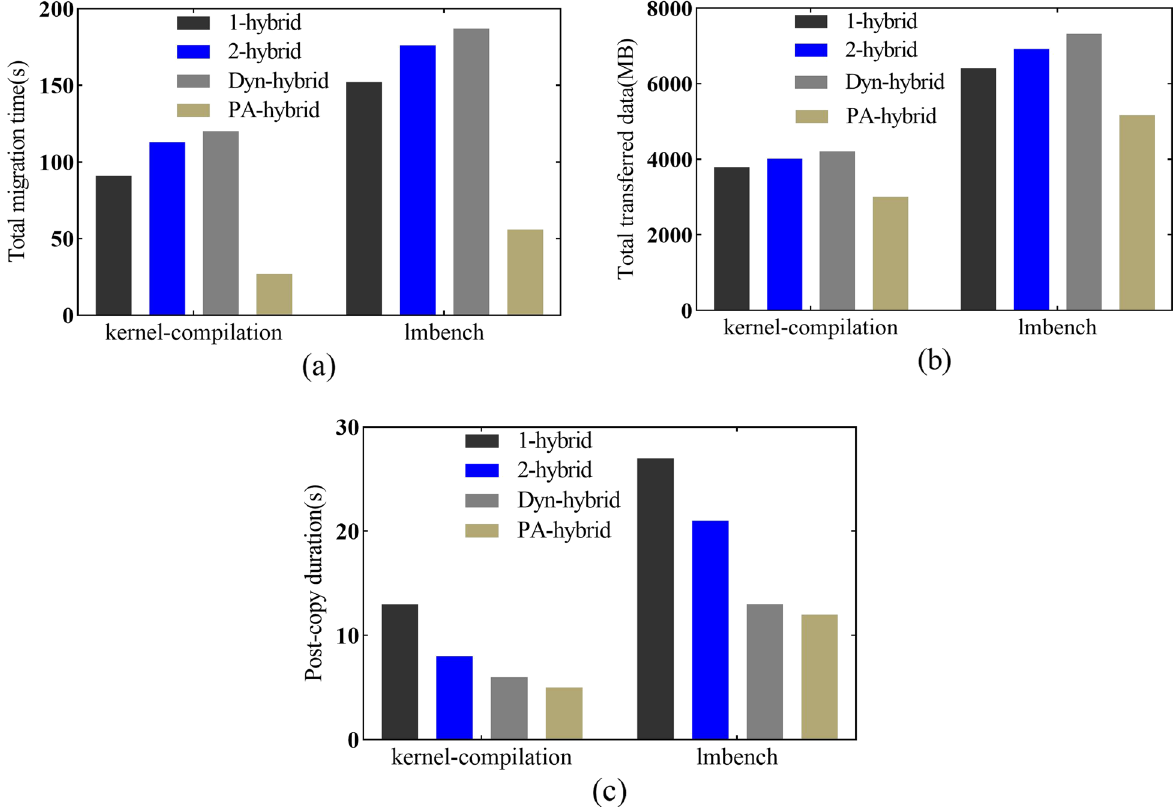
Fig. 13 Performance comparison for different workloads. a Total migration time. b Total transferred data. c Post-copy